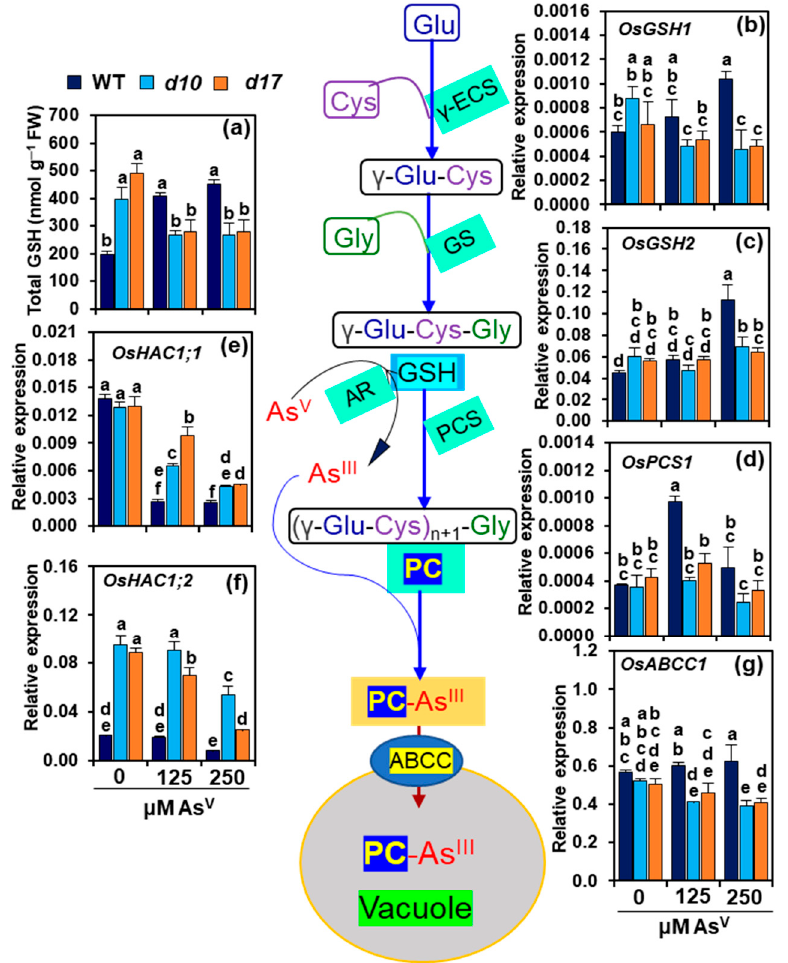
Figure 6. ( a – g ) Glutathione (GSH) biosynthesis and GSH-assisted arsenic detoxification in the shoots of wild-type (WT) and d10 and d17 mutant plants exposed to different concentrations of sodium arsenate (Na 2 AsO 4 ; 0, 125 and 250 μ M As V ). Total GSH content ( a ), and relative expression of genes involved in the biosyntheses of GSH ( OsGSH1 ( b ) and OsGSH2 ( c )), phytochelatin synthase, PCS ( OsPCS1 ( d )), arsenate reductase, AR ( OsHAC1;1 ( e ) and OsHAC1;2 ( f )) and C-type ATP-binding cassette, ABCC ( OsABCC1 ( g )) were determined in the shoots of three genotypes on day 3 of As V treatments. Represented numerical data are the means with standard errors ( n = 3 biological repeats). Significant differences ( p < 0.05) among the treatments are denoted by distinct alphabetical letters according to a least significant difference test. As III , arsenite; Cys, cysteine; FW, fresh weight; Glu, glutamate; Gly, glycine; γ -ECS, γ -glutamyl cysteine synthetase; GS, glutathione synthetase, HAC, high arsenate content; PC, phytochelatin.